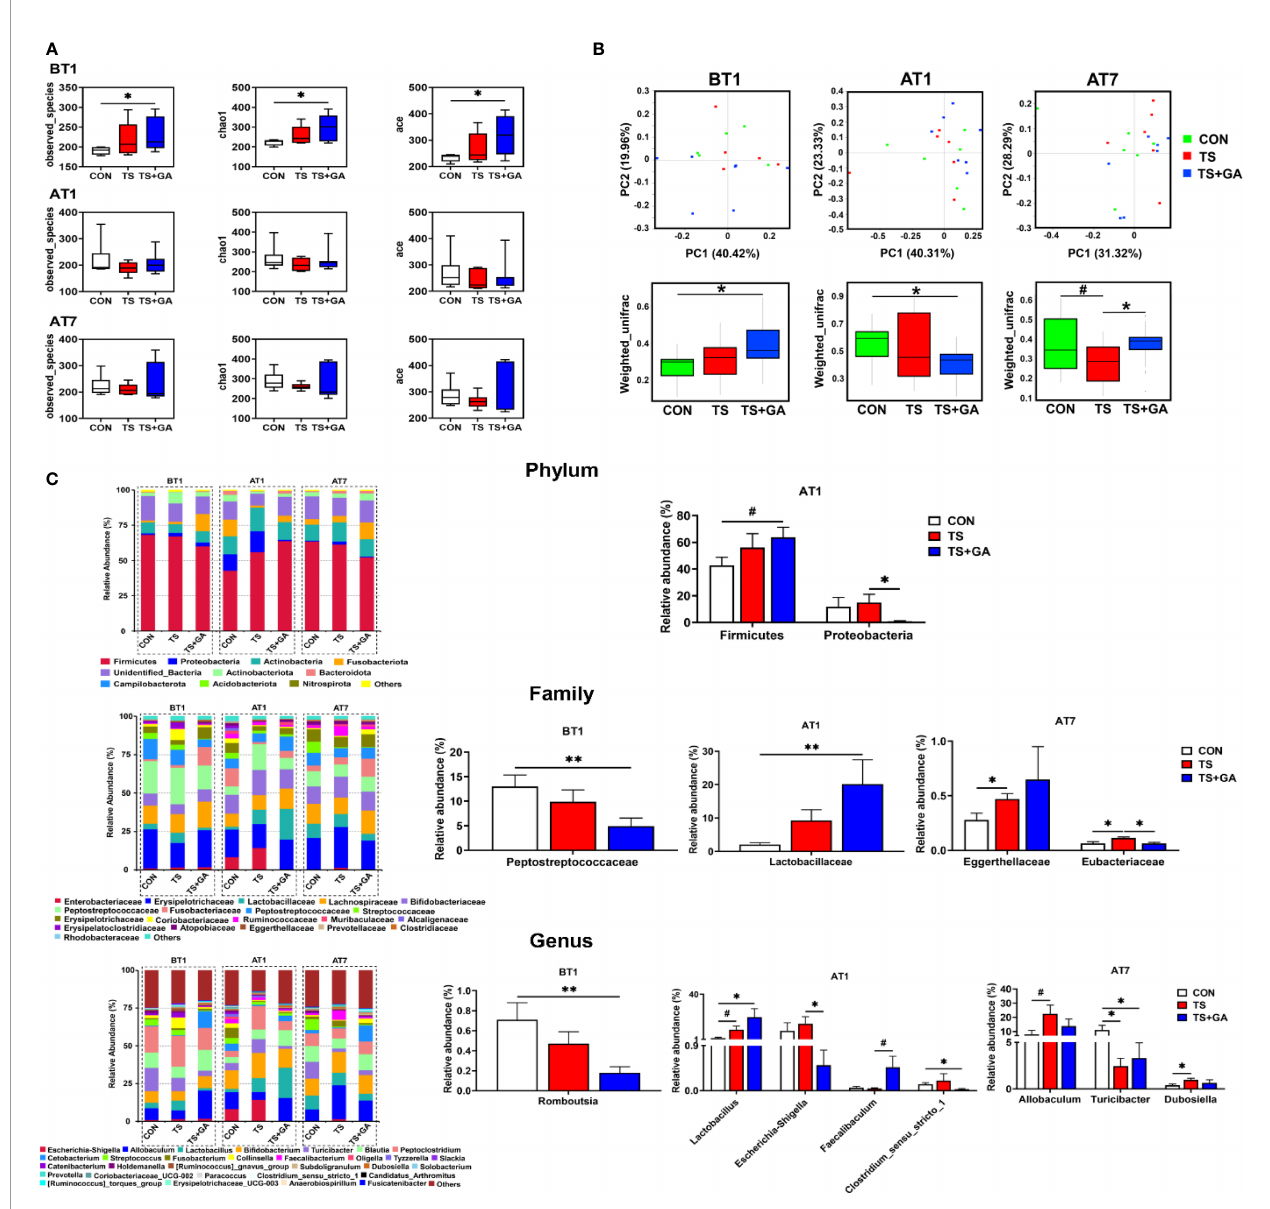
FIGURE 3 | Effect of gallic acid (GA) on gut microbial composition and structure in puppies (n = 6 or 7). Alpha diversity (A) , principal coordinate analysis (PCoA) based on weighted UniFrac distances (B) , predominant fecal microbial communities, and different bacteria at the phylum, family, and genus levels (C) . The symbol (*) indicates statistically signi fi cant differences between two groups (* p < 0.05 and ** p < 0.01), and the symbol (#) represents difference tendency (# p < 0.10). BT1, the 1st day before transportation; AT1, the 1st day after transportation; AT7, the 7th day after